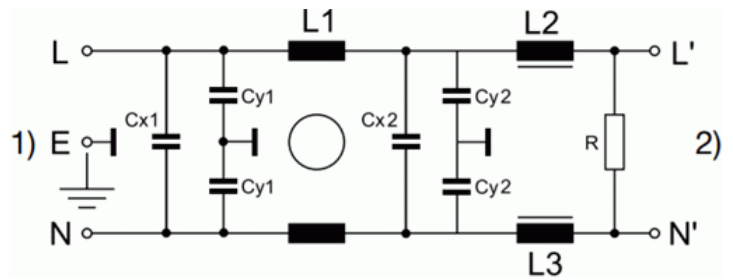
Figure 6. Schematics of the Electromagnetic Compatibility (EMC) filter 2055.